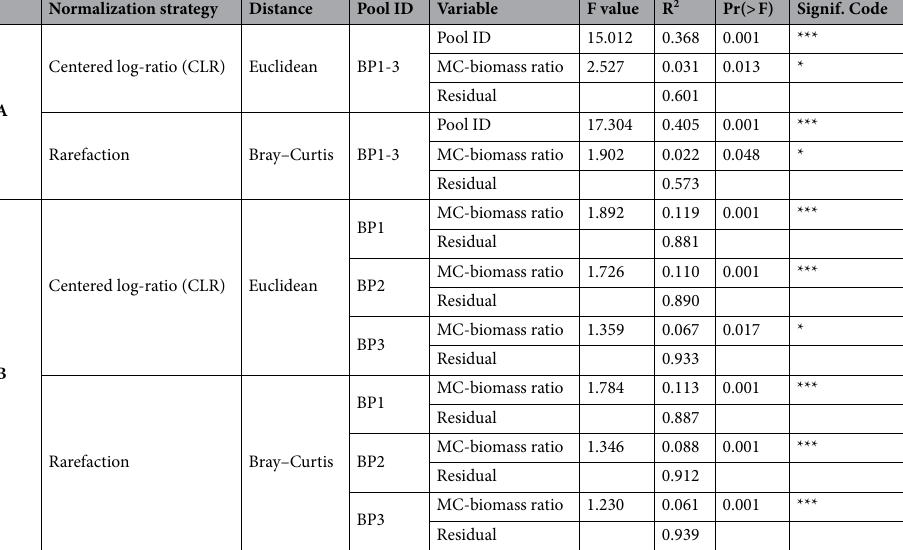
Fig. 4b, S4), as reported for untransformed datasets (Fig. 3, S2 and Table S3). However, in addition, transformed libraries also clustered according to their biomass, i.e. LBM and HBM libraries were represented by two separate clusters (R 2 : 0.045, p- value < 0.001, Fig. 4b). As observed for the untransformed data (Fig. 3b), the PCA in Fig. 4b indicated that microbial communities of bovine fecal pools BP1 and BP2 are more similar to each other than to BP3, which is consistent with their sample composition (Table S1).